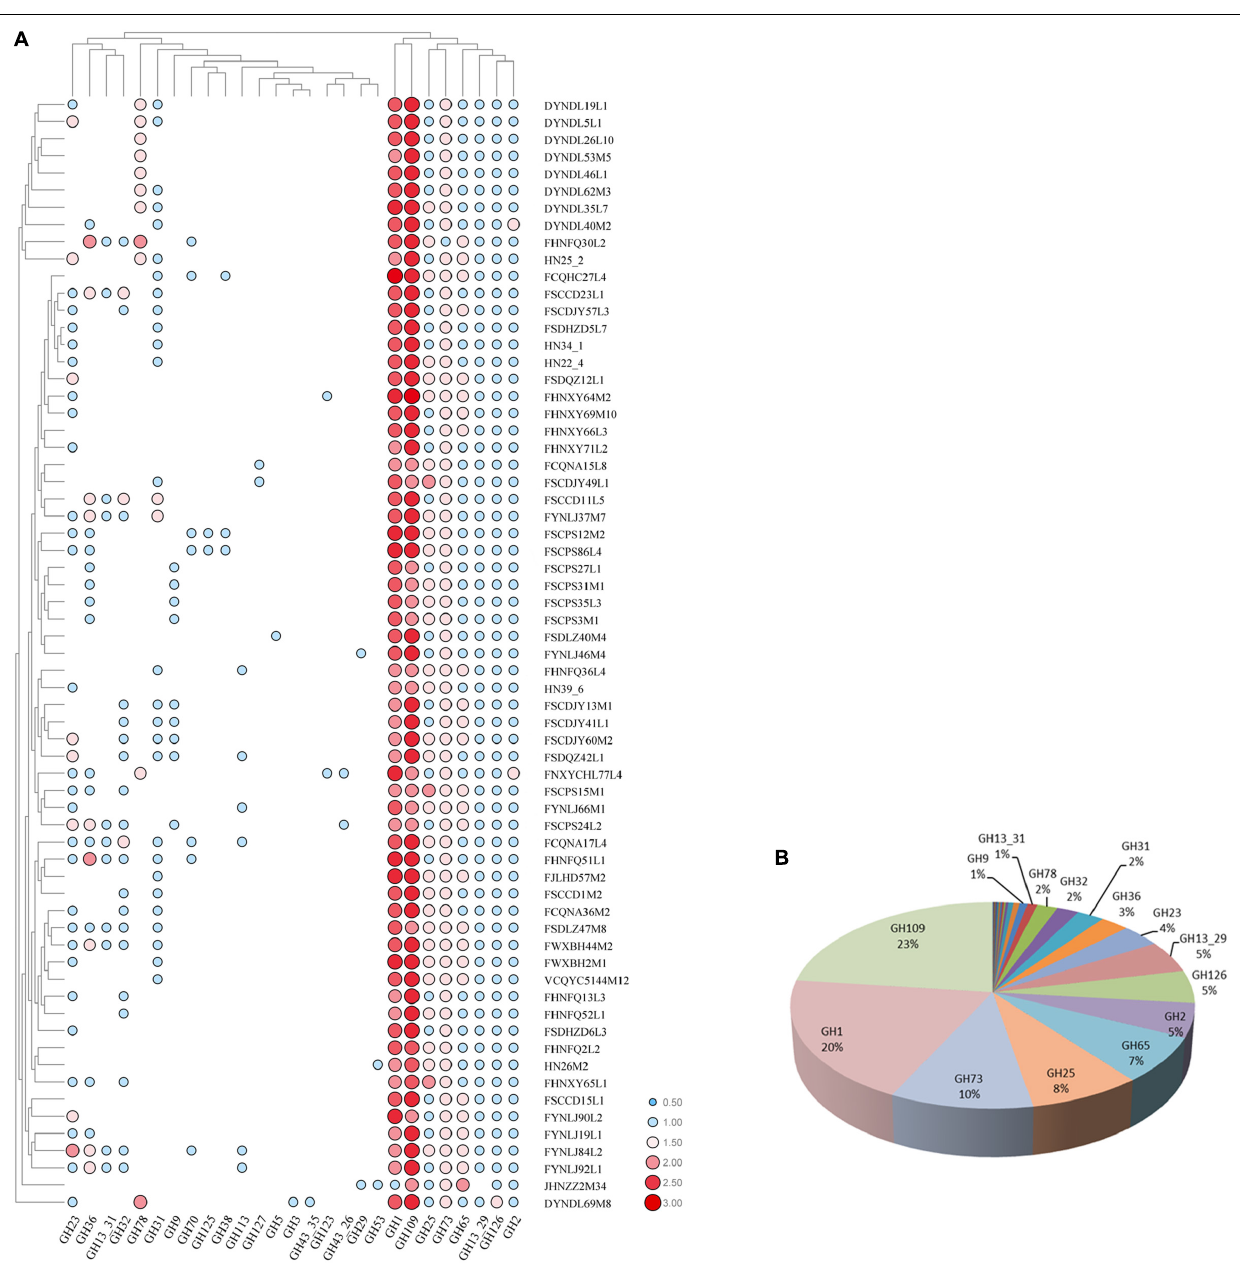
FIGURE 9 | GH families identified in P. pentosaceus. (A) Heatmap showing the distribution of GH families in 65 P. pentosaceus (The number of GH families was log scaled). The vertical axis represents the genomes that harbor GH families which was clustered according to the phylogenetic tree. The horizontal axis represents GH families predicted in P. pentosaceus . The color scales represent the number of GH families existed in each genome with white dot (as in blank) represents the absent of matches and red squares representing the highest number of GH families. (B) Pie chart indicating the percentage of each GH family identified in P. pentosaceus